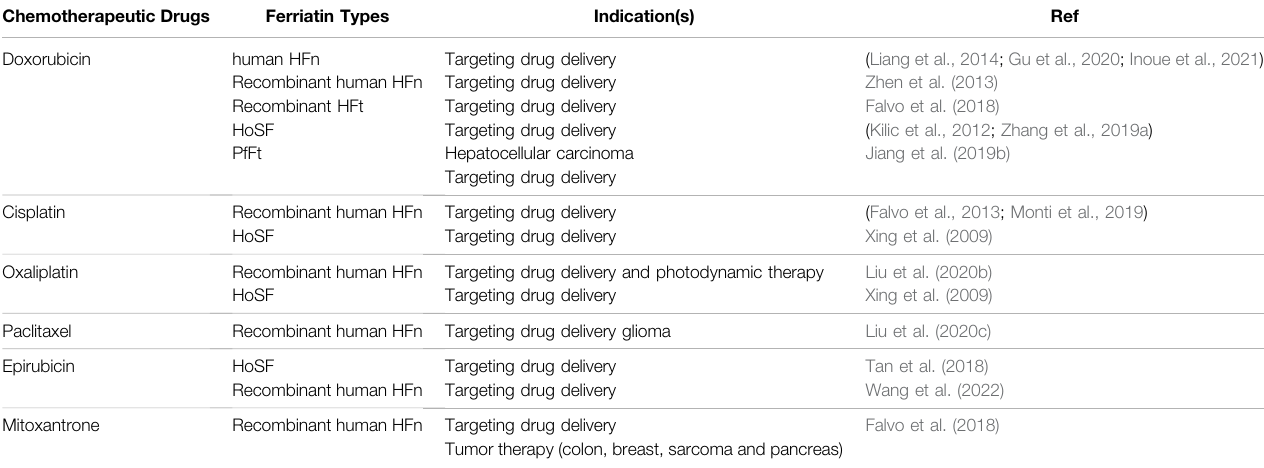
TABLE 3 | Ferritin nanoparticles in